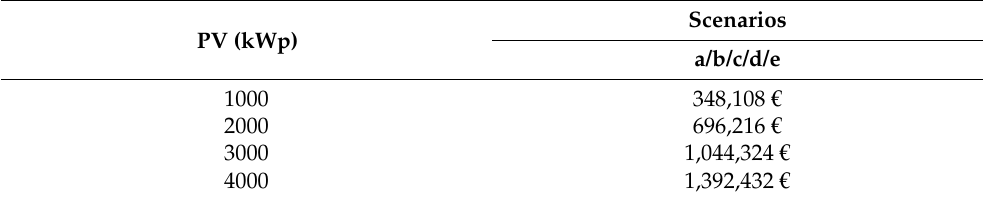
Table 3. Net Present Value when the uncoordinated charging is applied.